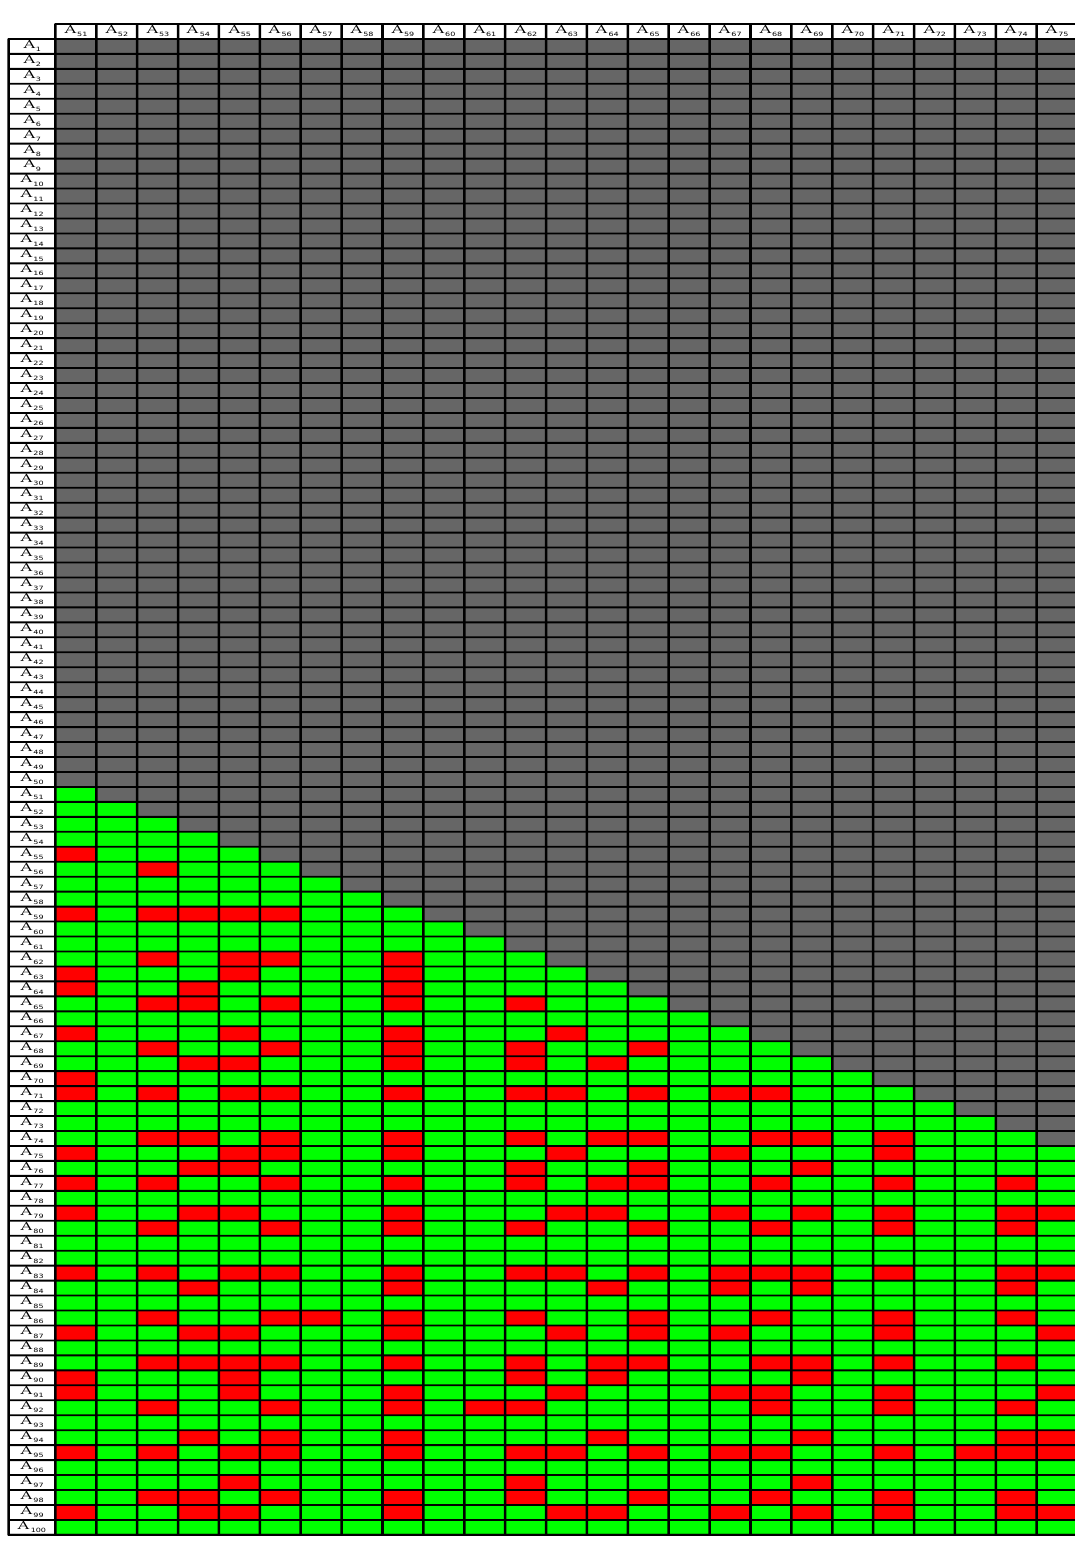
Table 4 . Analyzed theories for ( A n ; A m ) with n = 1 ; : : : 100 and m = 51 ; : : : 75.